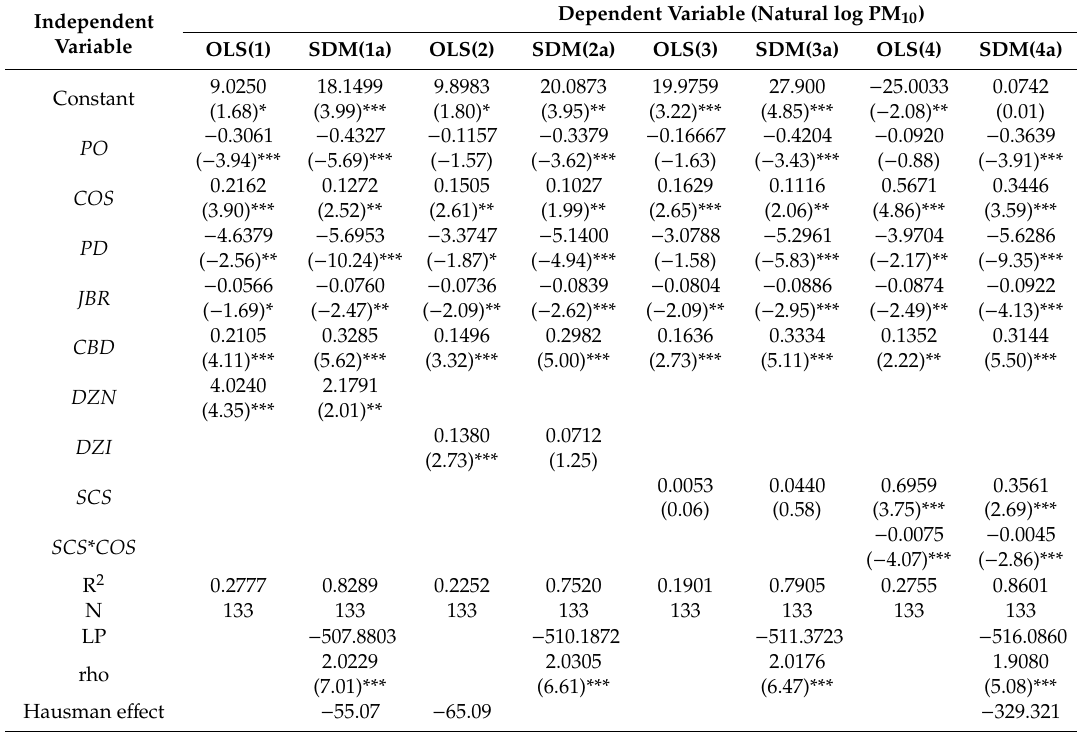
Table 4. OLS and SDM regression results-PM